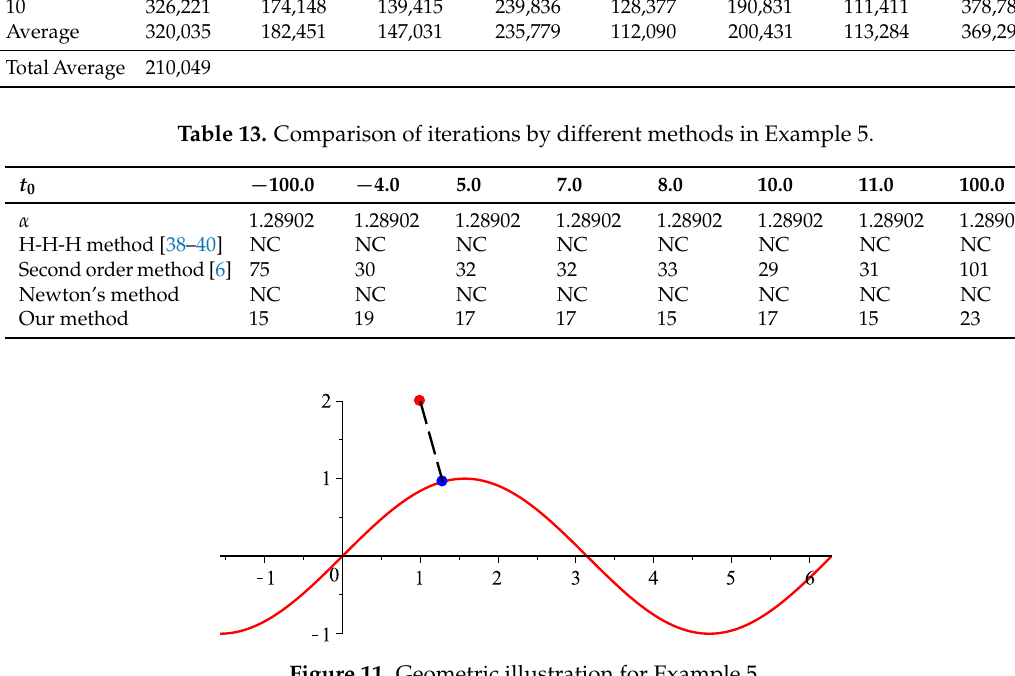
Figure 11. Geometric illustration for Example